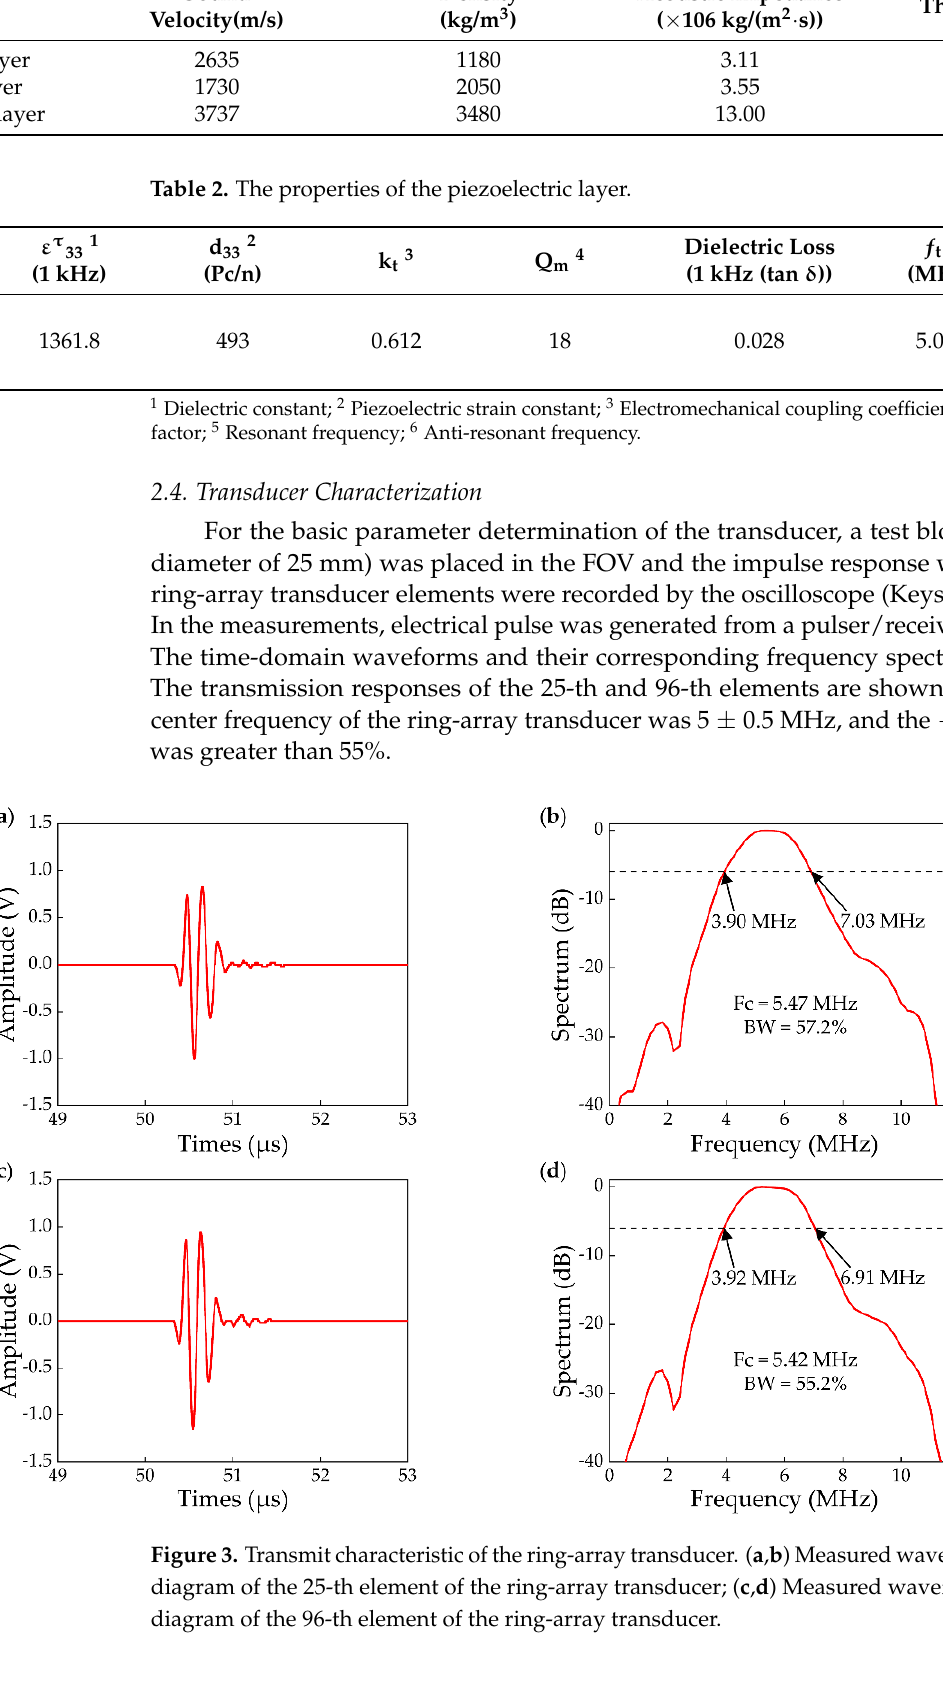
Table 1. The design parameters of the ring-array transducer.